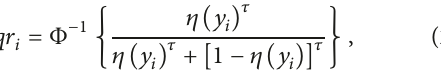
and the data set, it is convenient to define residuals that take into account the contribution of each observation to the goodness-of-fit